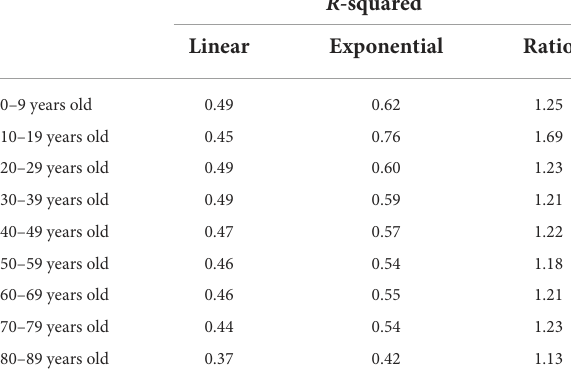
TABLE 2 Fitting deterministic linear and exponential time trends to the evolution of the different age-groups over the second pandemic wave in